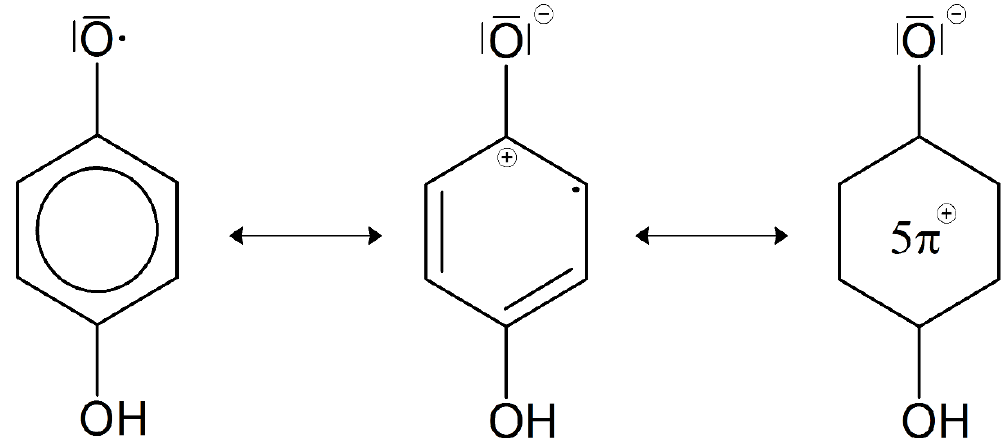
Figure 1. Intramolecular mesomeric structures of hydroquinone according to Ziechmann,1980, p. 142.